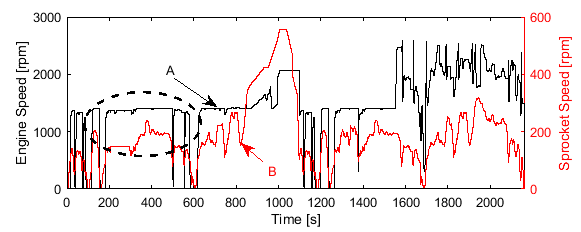
Figure 10. Engine (A) and Sprocket (B) speed profiles